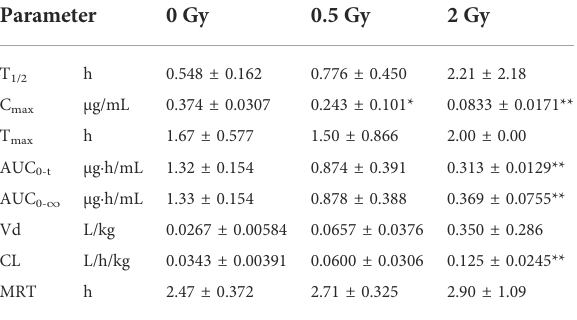
TABLE 2 Pharmacokinetic parameters of apatinib (45 mg/kg, intragastrical administration) in rat plasma after abdominal X-ray irradiation (Mean ± SD, n =